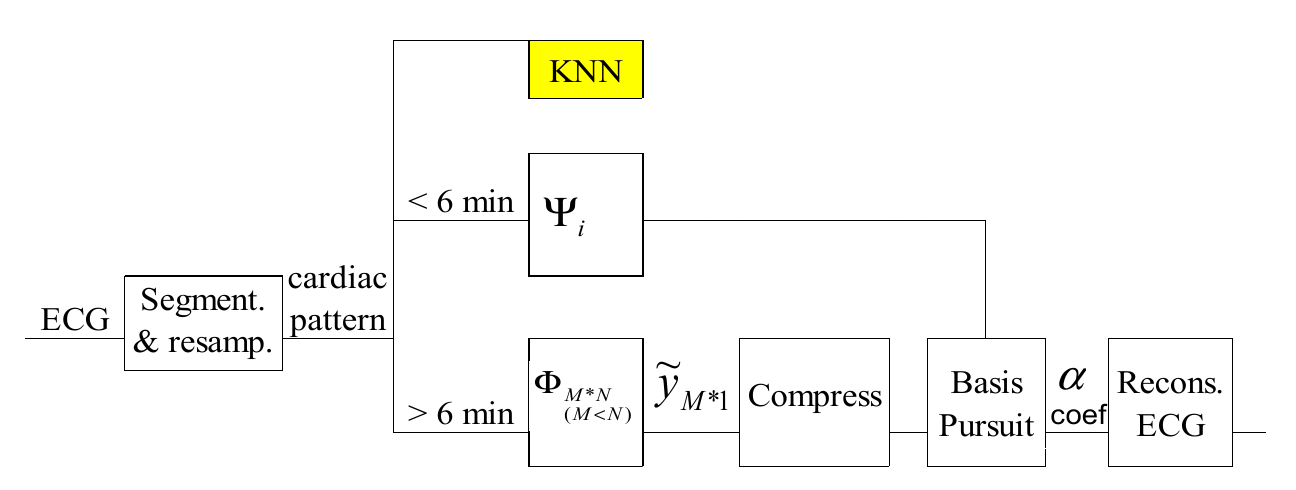
Figure 2. Principle of the PSCCS method.